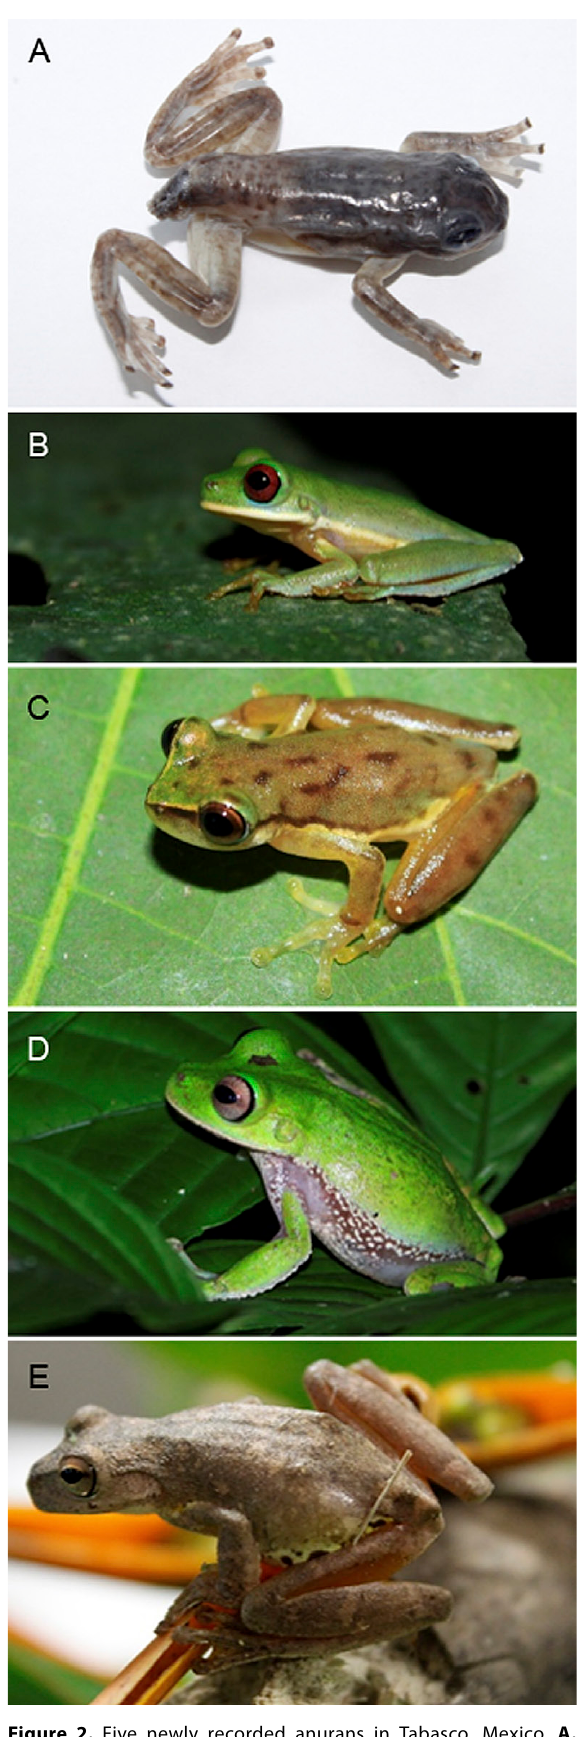
Figure 2. Five newly recorded anurans in Tabasco, Mexico.